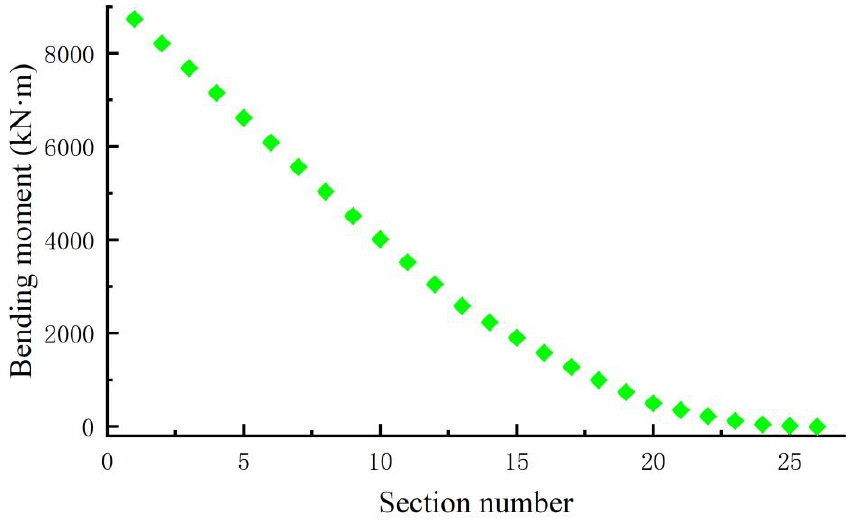
Figure 28. Bending moment on blade sections.